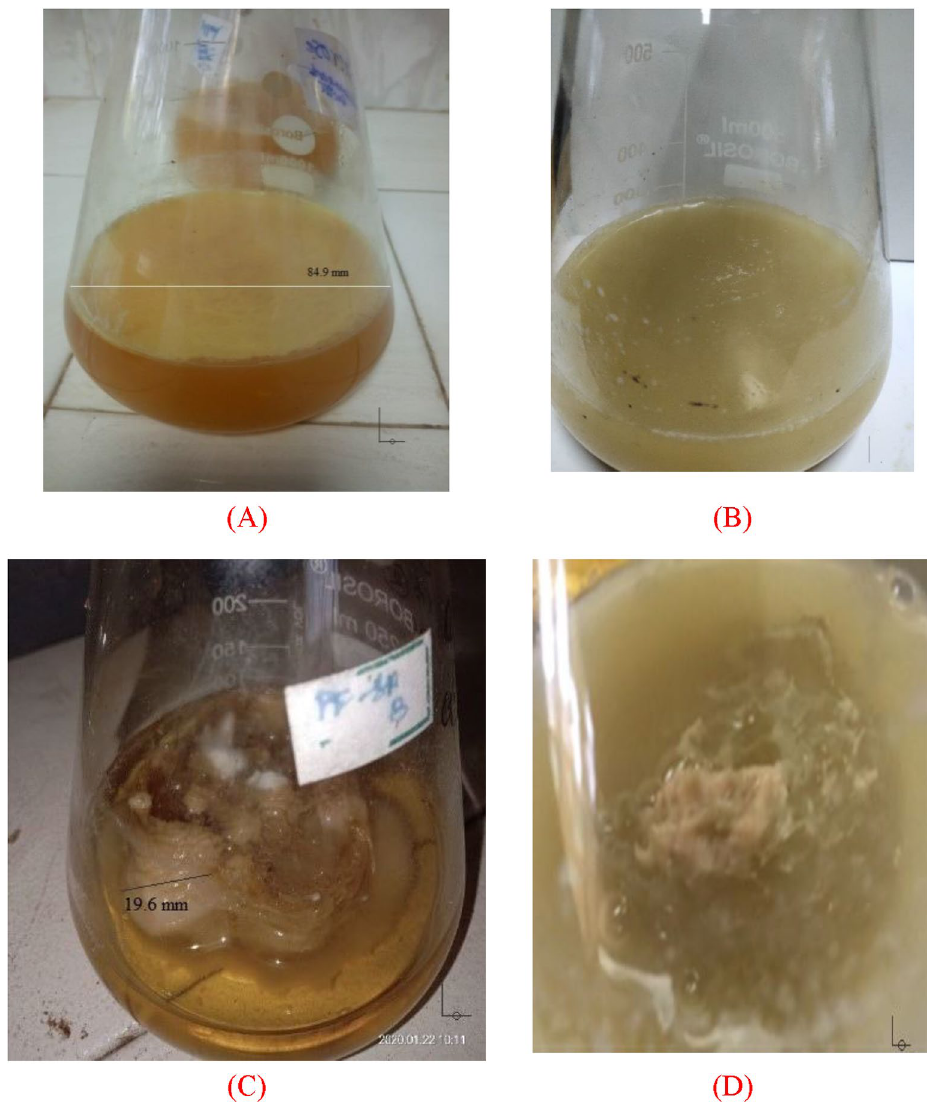
Figure 3. Photgraphic images for BC formation ( a ) static condition without LA matrix; ( b ) shaking condition without LA matrix; ( c ) static condition with LA matrix; ( d ) shaking condition with LA